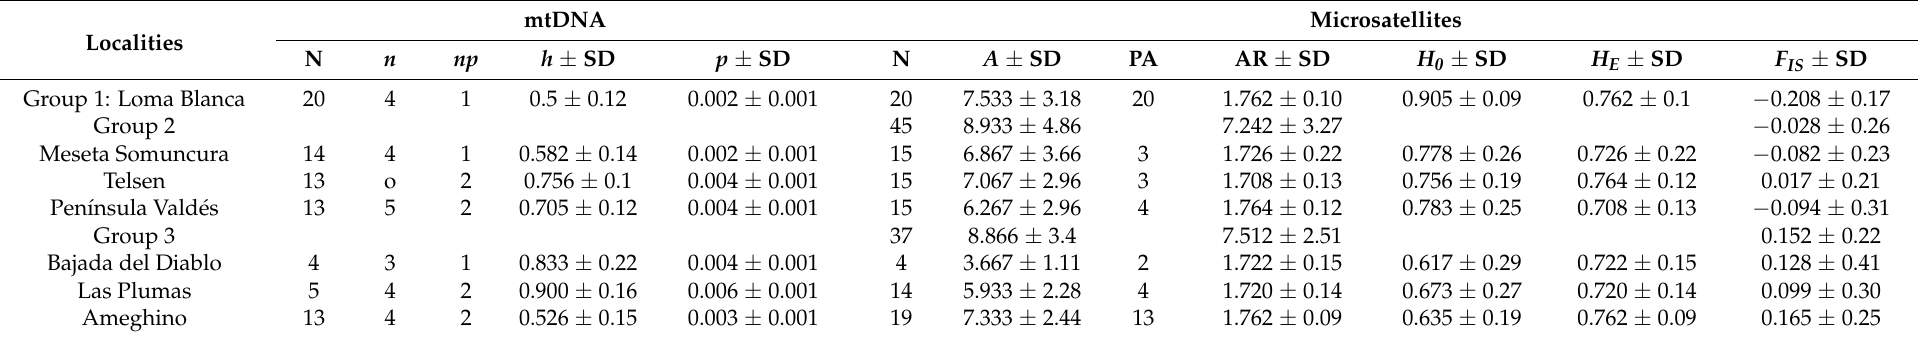
N, number of samples; n , number of haplotypes; np , number of private haplotypes; h , haplotype diversity; π , nucleotide diversity; A , number of alleles per locus; PA, private alleles; AR, mean allelic richness; H E , expected heterozygosity; H 0 , observed heterozygosity and their respective standard deviations